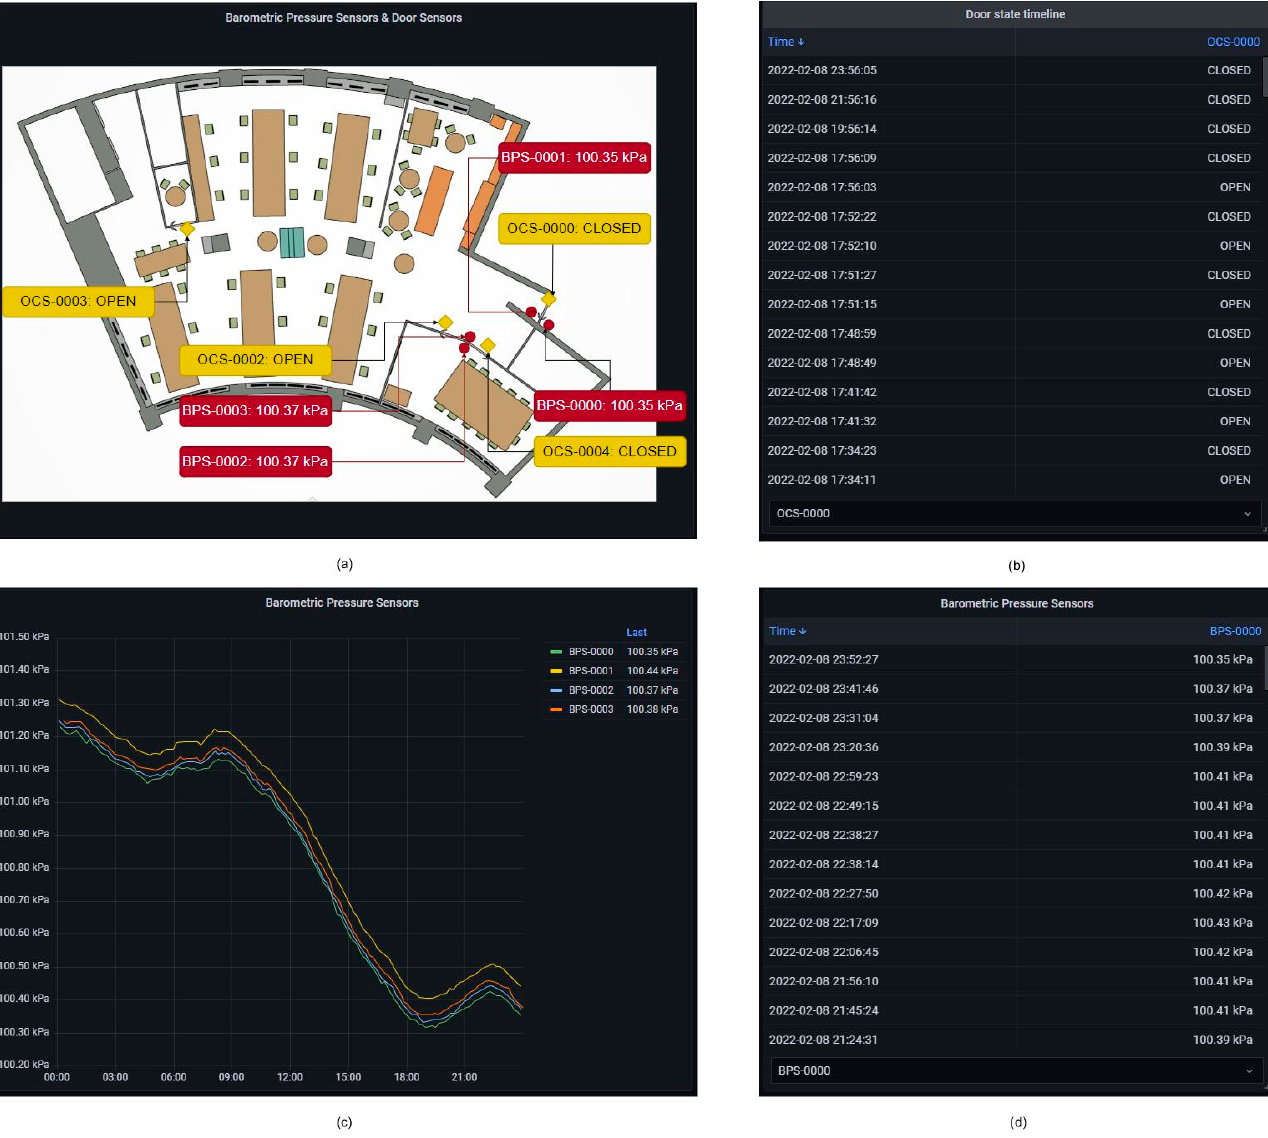
Figure 11. Barometric pressure sensors and door sensors. ( a ) Panel shows the locations and latest readings of installed barometric pressure sensors and door sensors. ( b ) Panel shows readings from OCS-0000. Drop down menu allows the selection of other door sensors. ( c ) Panels show the time- series data from the barometric pressure sensors. ( d ) Panel shows readings from BPS-0000. Drop down menu allows selection from other barometric pressure sensors.